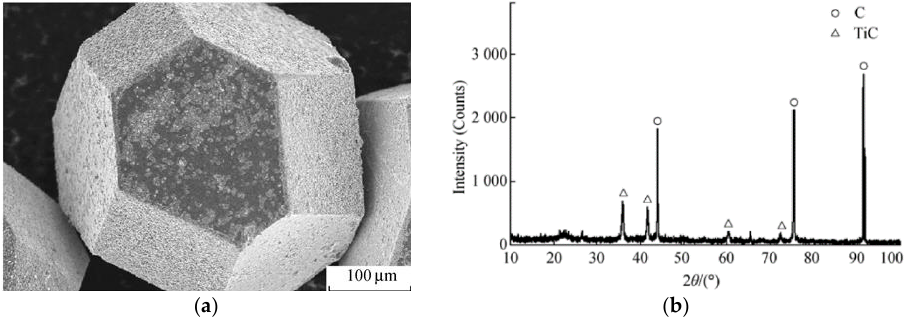
Figure 5. ( a ) SEM photograph; ( b ) XRD pattern of Ti-coated diamond particle surface [16]. Reproduced with permission from Journal of the Chinese Ceramic Society, 2011.